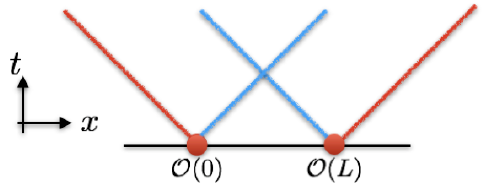
, and 4 (cid:25)gh with L 4 h +1 L 4 h +1 , and otherwise zero. L 4 h +1